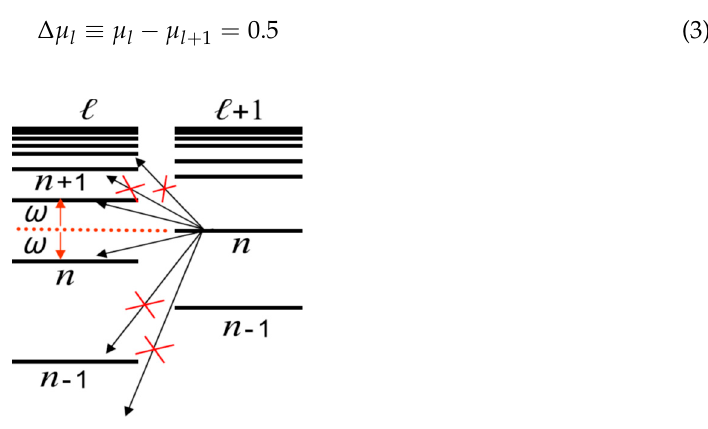
Figure 1. Scheme of Rydberg atomic levels, illustrating the effect of the double Stark (Förster) resonance in { l + 1, l } atomic series on blocking of the “long” transitions between remote states.